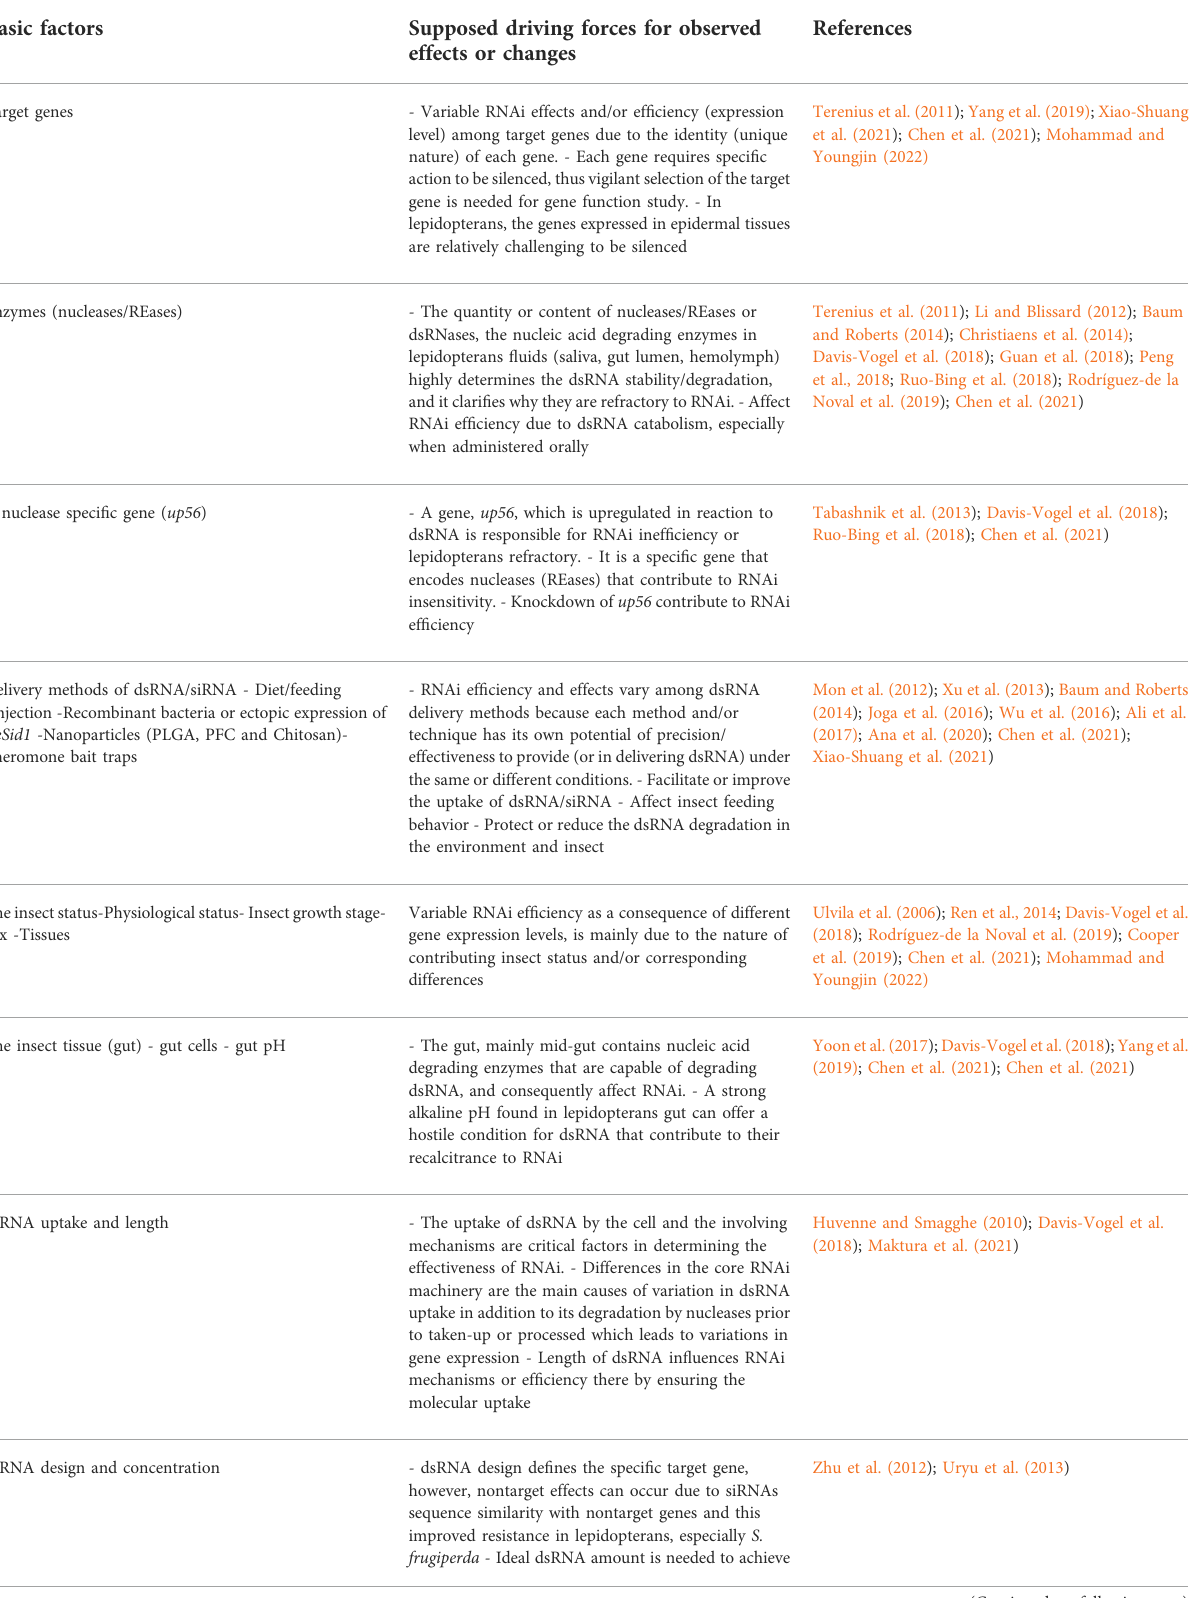
TABLE 2 Some of the factors in fl uencing the ef fi ciency of RNAi application in S. frugiperda management. Basic